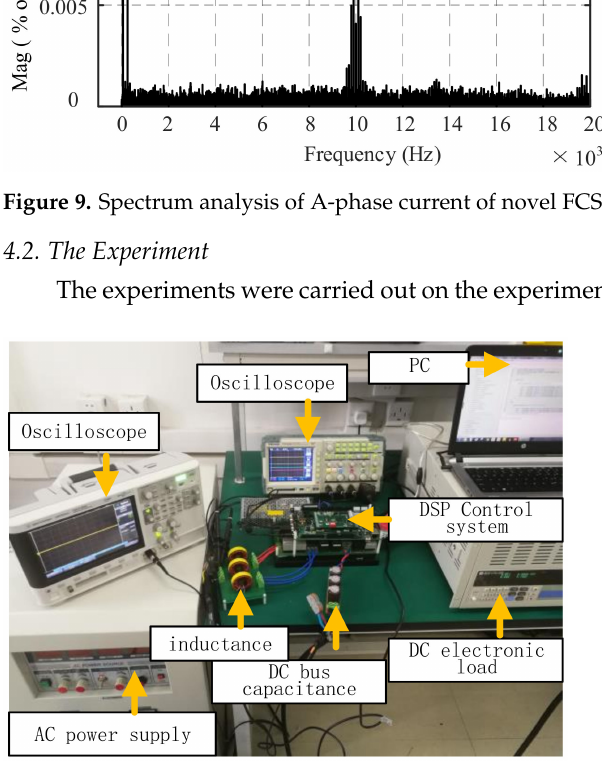
Figure 10. Two-level three-phase PWM rectifier experimental